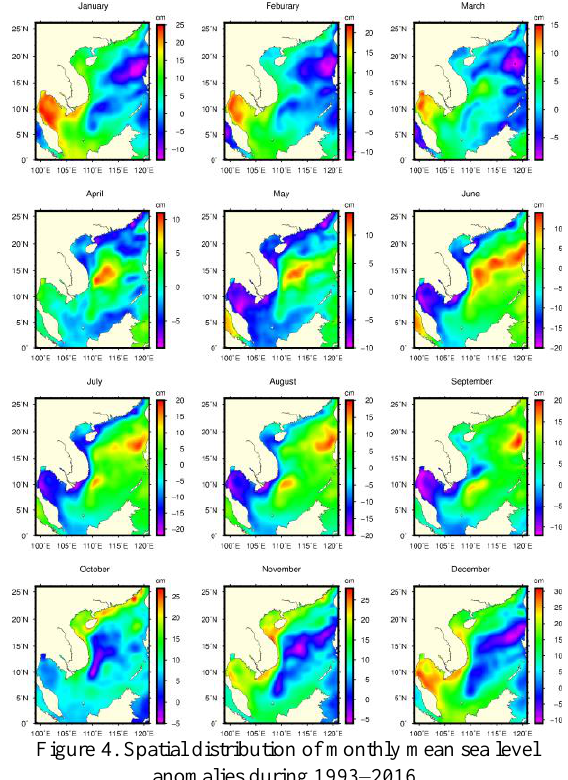
Figure 4. Spatial distribution of monthly mean sea level anomalies during 1993–2016.